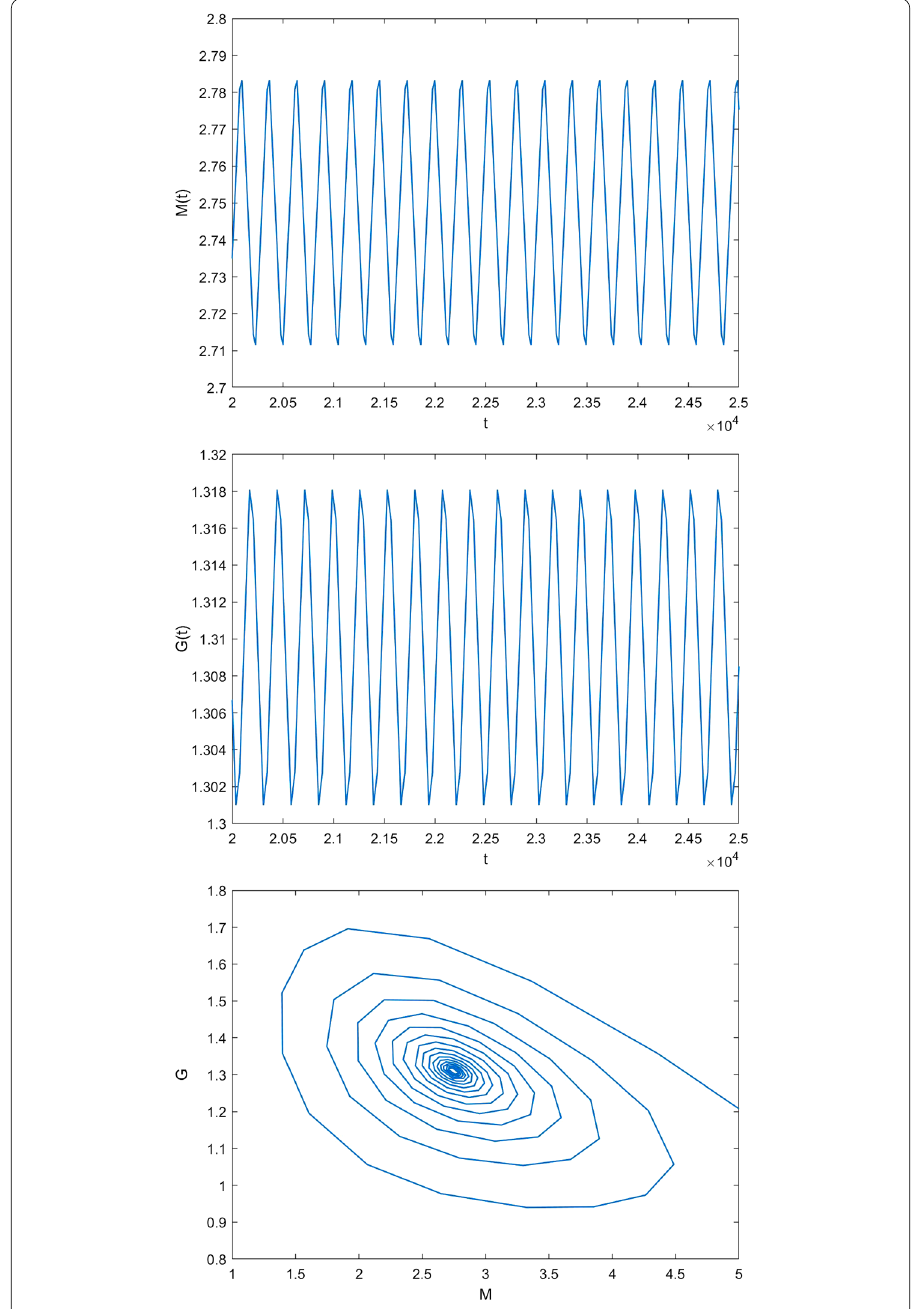
Figure 4 A computer simulation of the system (2.1)–(2.2) with a 1 = 0.1450, a 2 = 0.6937, b 1 = 0.0596, b